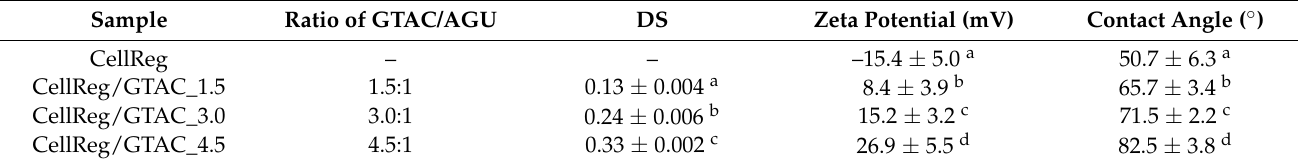
Table 1. List of the non-modified and modified regenerated cellulose samples with the corresponding ratio of GTAC to anhydroglucose units (AGU), degree of substitution (DS), zeta potential and contact angle (with water) 1